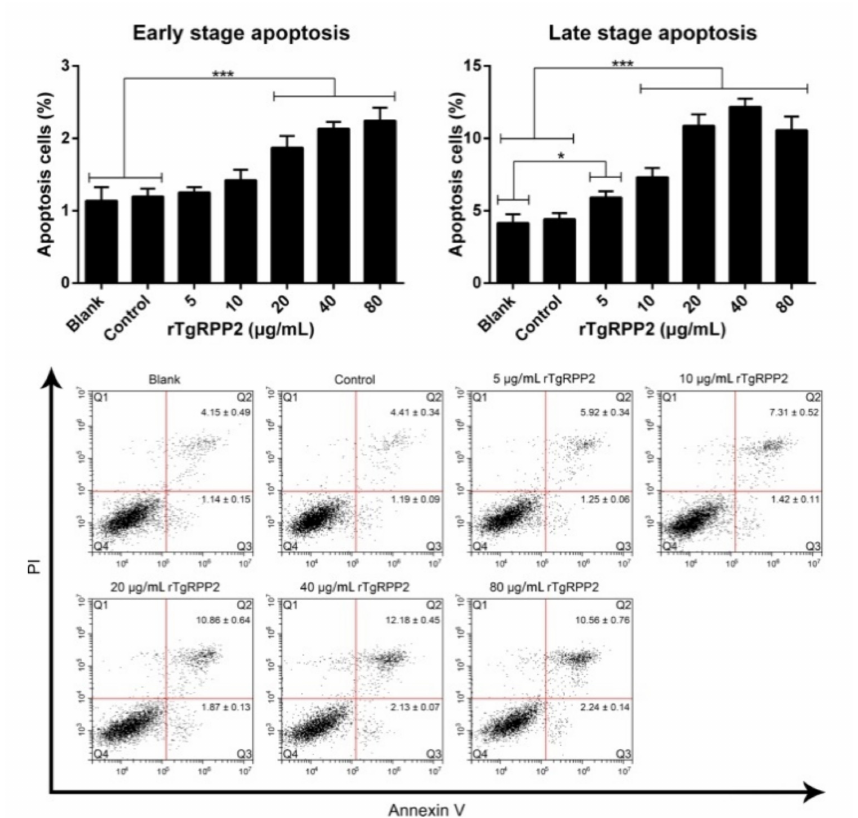
Figure 4. Recombinant TgRPP2 induces the apoptosis of murine Ana-1 cells. Ana-1 cells were preincubated with different concentrations of rTgRPP2 for 48 h. Quadrant Q3 represents early- stage apoptosis (annexin V+/PI − ), while quadrant Q2 represents late-stage apoptosis (annexin V+/PI+). Values were evaluated using one-way ANOVA analysis, followed by Dunnett’s test, and expressed as the mean ± standard deviation of three independent experiments ( n = 3). * p < 0.05 and *** p < 0.001 compared with the blank group or the control group.